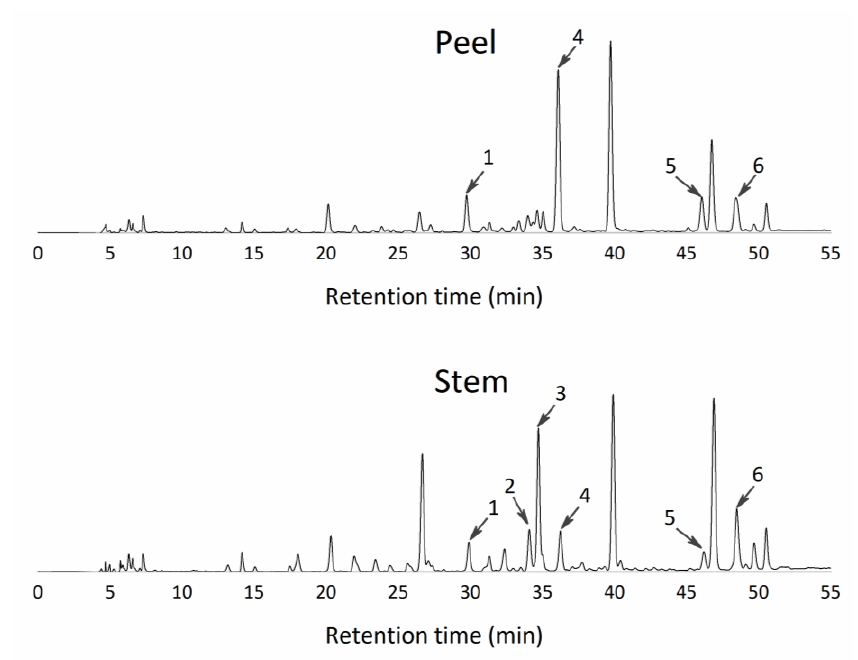
Figure 3. Chromatograms of the main peaks found and identified as free phenolic compounds of pineapple by-products at a wavelength of 320 nm. The liquid fraction of peels and the liquid fraction of stems. 1 — Chlorogenic acid; 2 — p-hydroxybenzoic acid; 3 — 2,5-dihydroxybenzoic; 4 — Caffeic acid; 5 — Syringaldehyde; 6 — Ferulic acid.